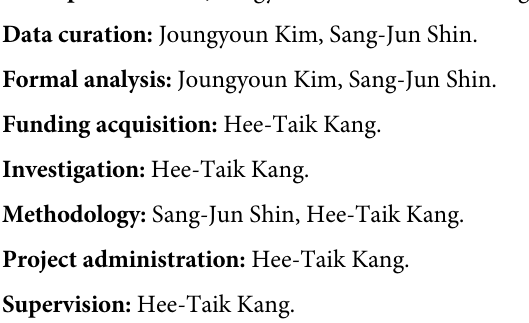
S1 Fig. Kaplan-Meier estimates for cerebrovascular diseases according to triglycerides-glu-